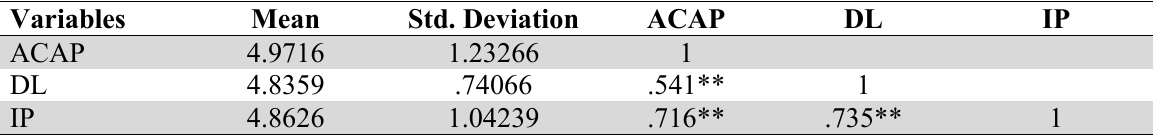
Mean, Std. Deviation and correlation between absorptive capacity, dominant logic and innovation per- formance Variables